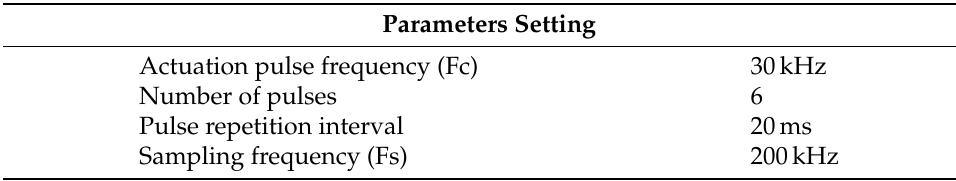
Table 1. Parameter settings used for the transceivers’ actuation and data